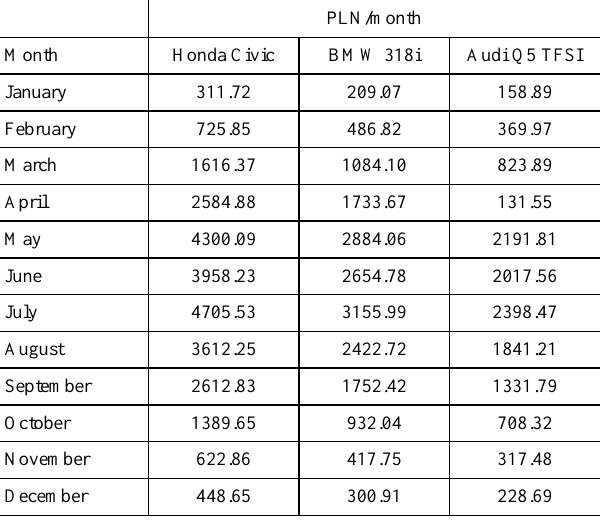
Table 21. Economical savings provided by PV system usage to power EV petrol vehicles compared